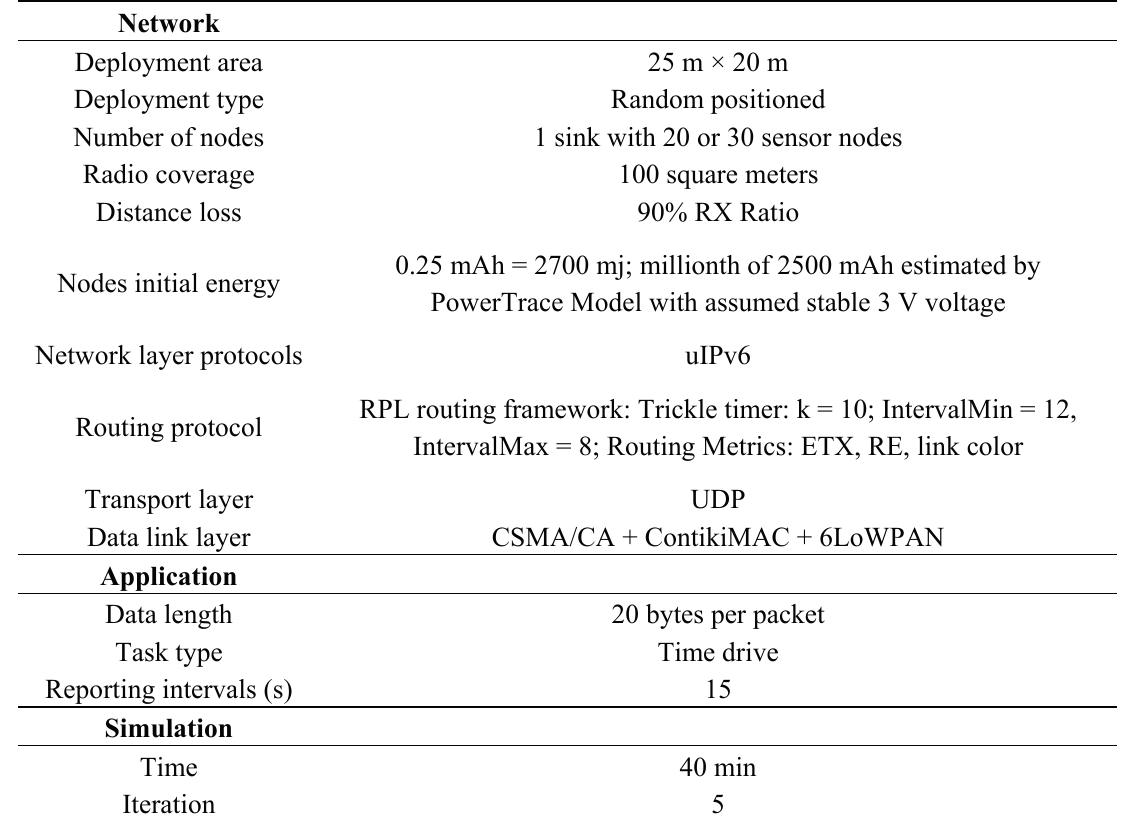
Table 6. Network and simulation configuration for validation of